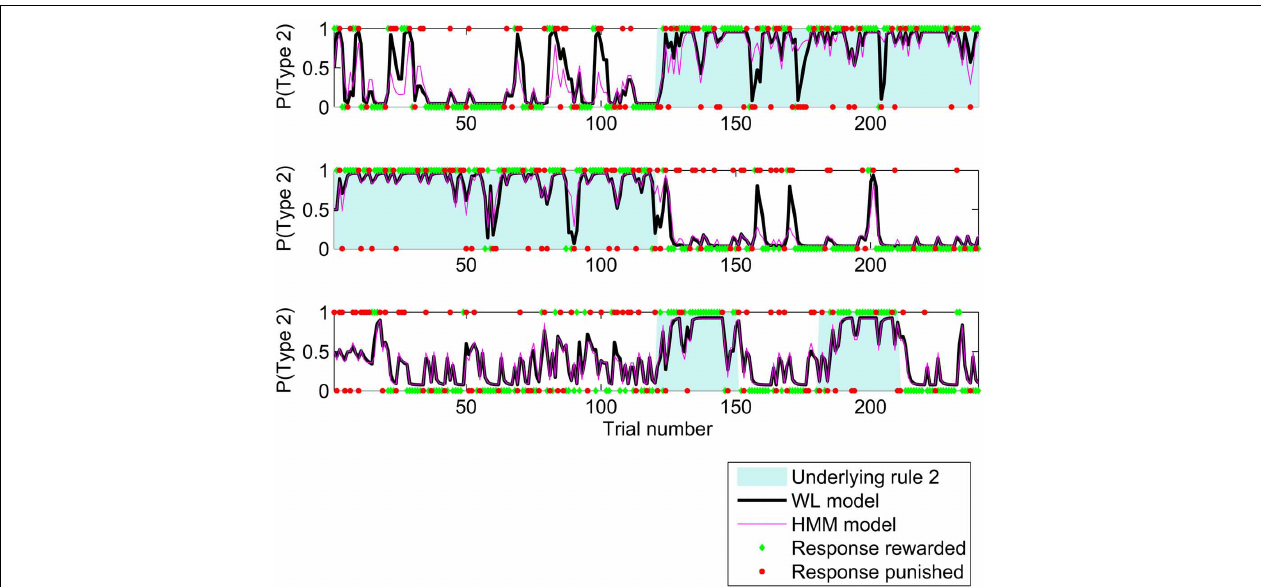
FIGURE 3 | Probability of a type 2 response calculated by HMM and WL models using the parameters fit to behavior by three participants for the first 240 trials of the study. Unshaded areas indicate that, experimentally, rule 1 applied and shaded areas that